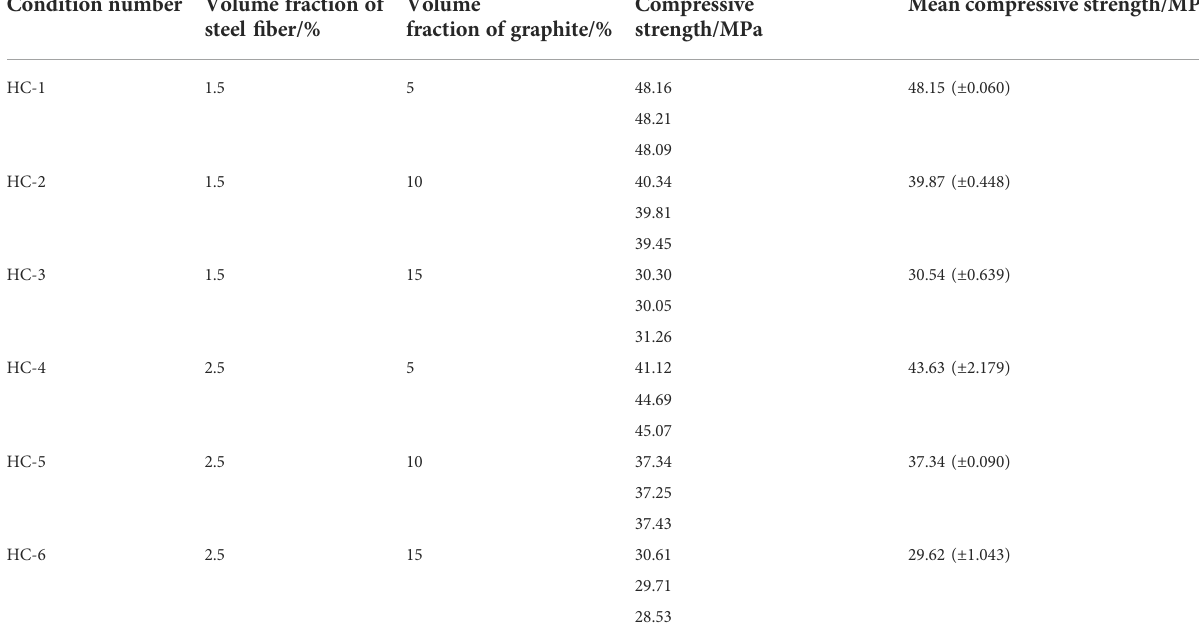
TABLE 19 Test value of compressive strength of the